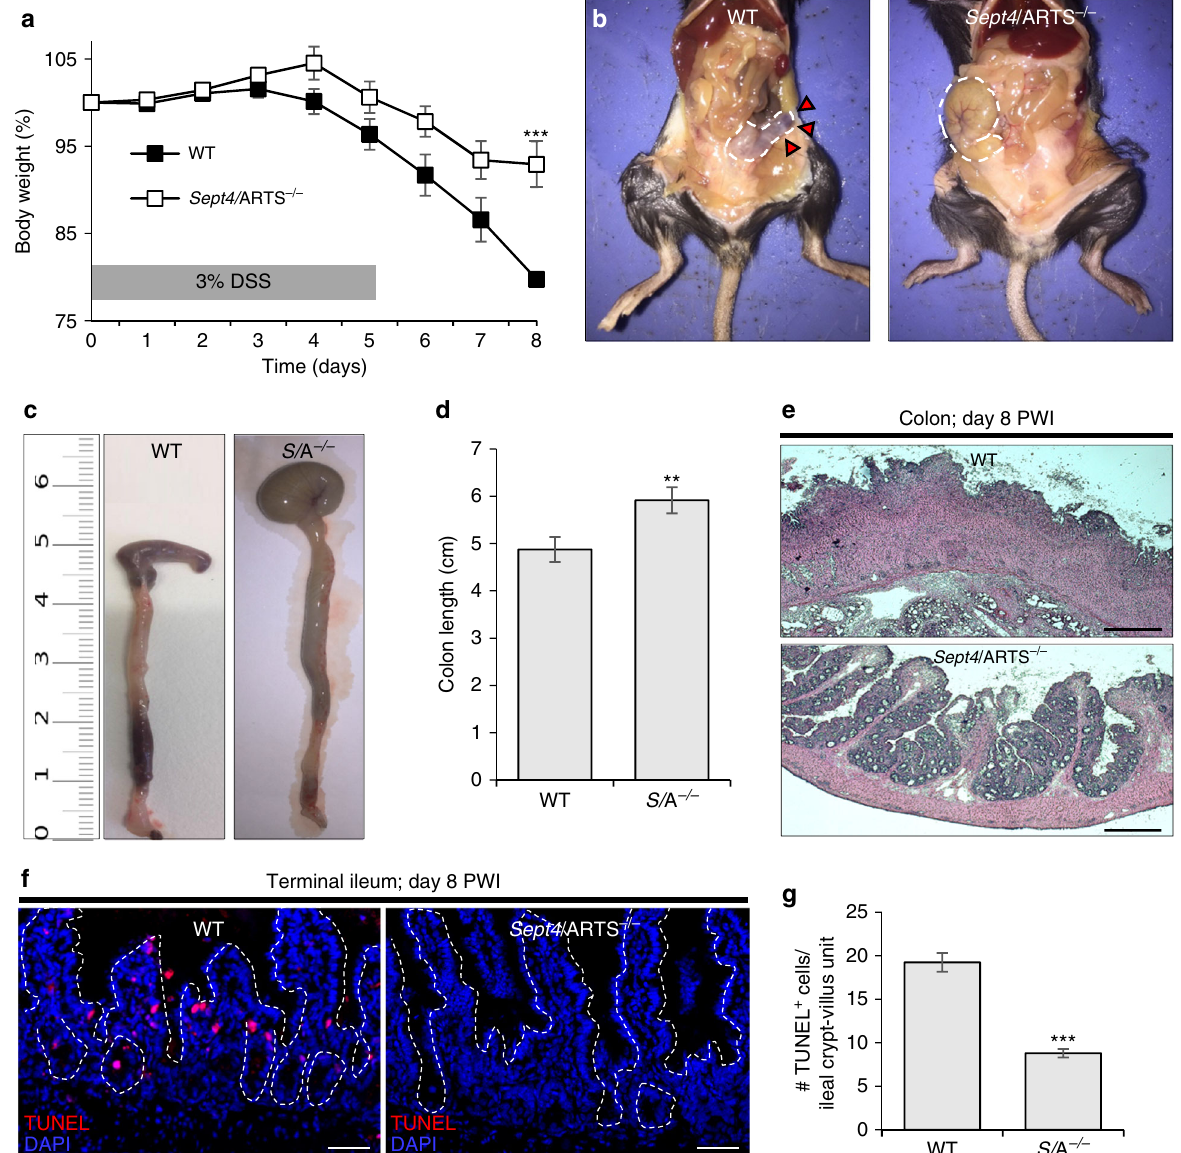
Fig. 6 Mice lacking Sept4 /ARTS exhibit enhanced resistance against intestinal wounding. a Body weight (%) of wild-type (WT) and Sept4 /ARTS − / − ( S /A − / − ) mice depicted over days 0 – 8 of dextran sodium sulfate (DSS; 3% w/v) administration [*** P value < 0.002 was determined by comparing the same time point using unpaired two-tailed Student ’ s t test]. b WT and S /A − / − mice sacri fi ced at day 8 post wound in fl iction (PWI). Dissection through the abdominal wall reveals that the S /A − / − cecum of the large intestine retains regular shape, size and color, in contrast to the WT (red arrows). Dashed white line indicates cecum. c Extracted colons from WT and S /A − / − mice at day 8 PWI. Length is in cm. d Quanti fi cation of colon length (cm) PWI. e Hematoxylin and eosin (H&E) staining of resected colon tissue at day 8 PWI. f WT and S /A − / − terminal ileum at day 8 PWI stained for terminal deoxynucleotidyl transferase (TdT) dUTP nick-end labeling (TUNEL) + apoptotic cells. Dashed white lines demarcate crypt-villi units. g Quanti fi cations of number of TUNEL + apoptotic cells per crypt-villus unit post DSS treatment [ n = 3 mice per genotype]. ** P < 0.01 and *** P < 0.005 were determined by unpaired two-tailed Student ’ s t test, unless otherwise speci fi ed. Images and quantitations are representative of n = 11 mice per genotype unless otherwise indicated. Error bars represent ±s.e.m. All experiments were repeated at least twice. Scale bars: 50 µ m ( f ), 200 µ m ( e